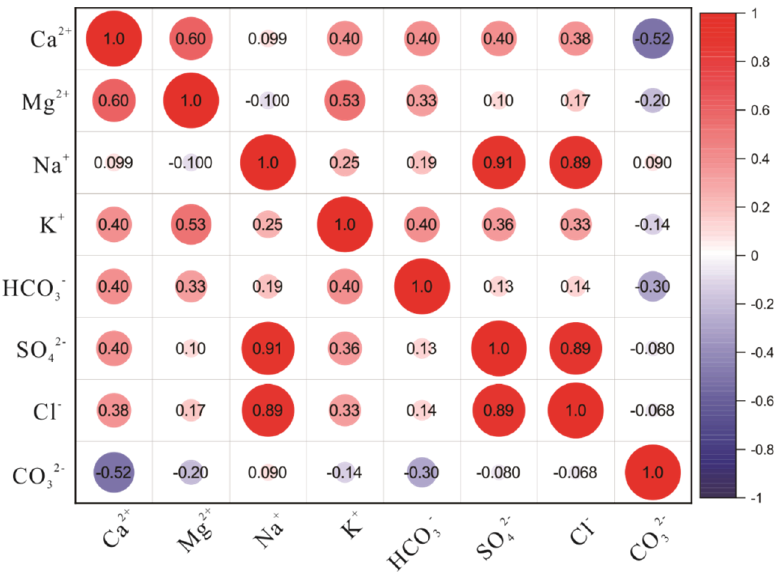
Figure 10. Correlation heatmap of hydrochemical parameters.